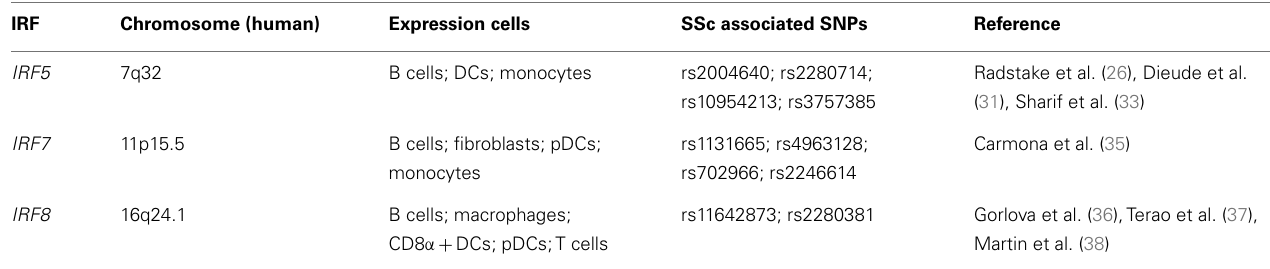
Table 1 | Polymorphisms in the interferon regulatory factors associated with systemic